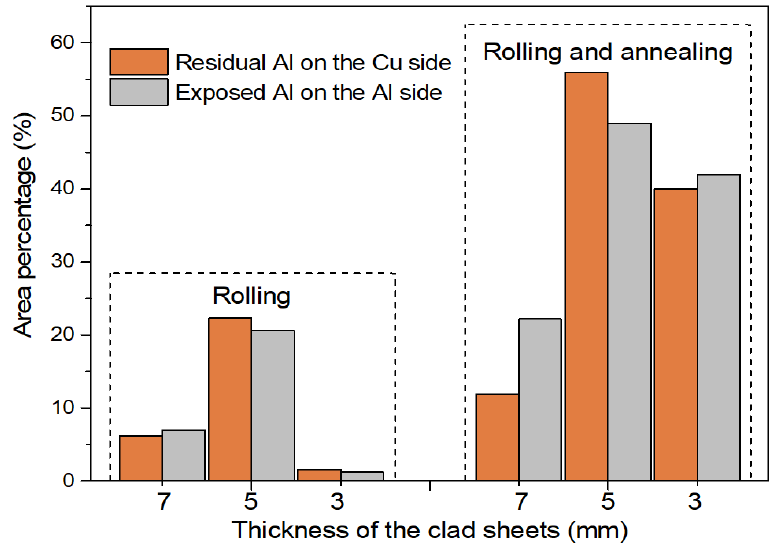
Figure 12. Areas percentage of the residual Al on the Cu side and exposed Al on the Al side with the clad sheet thickness